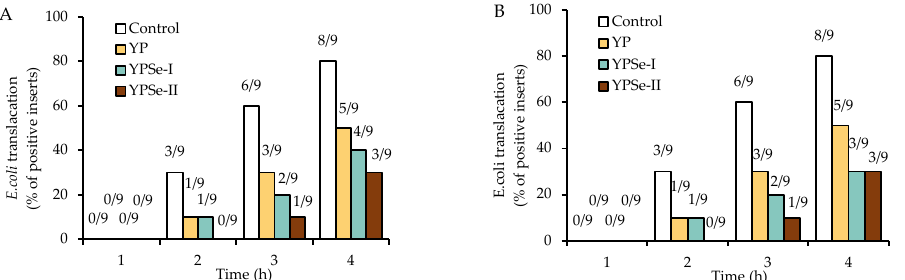
Figure 5. Effect of cell treatment with YP, YPSe-I, and YPSe-II at 40 μ g/mL for 12 ( A ) or 24 h ( B ) on E. coli translocation across IEC-6 cell monolayers. The first number above the columns indicates the E. coli- positive inserts, while the later one above the columns indicates the assessed inserts.